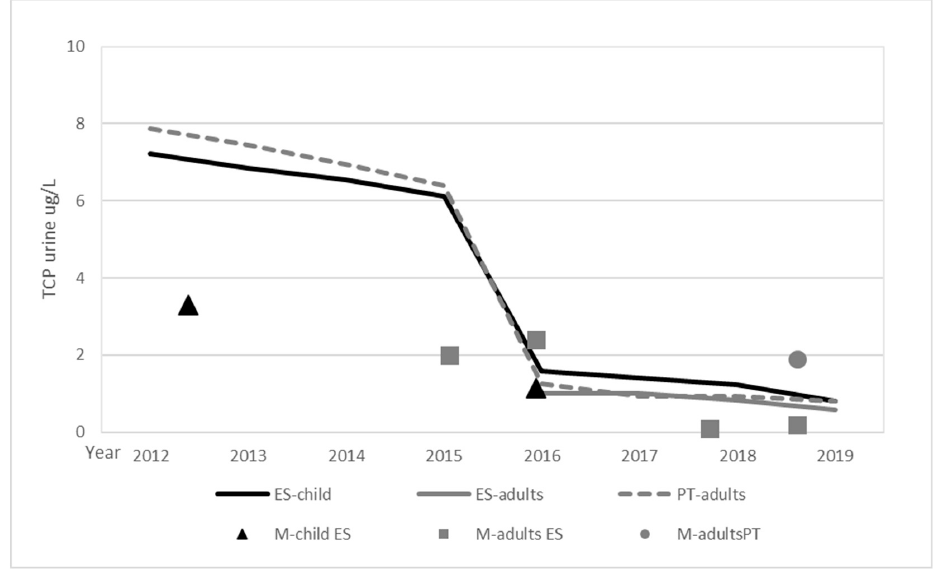
Figure 2. TCPy levels estimated from food (lines) vs. human monitoring (M-) for Spain and Portu-